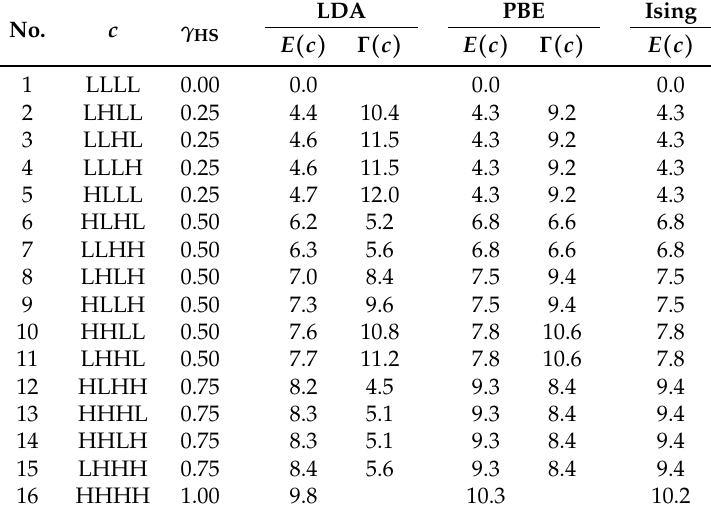
Table 1. Calculated total electronic energies per molecule, E ( c ) , Equation (5), and microscopic interaction parameters, Γ ( c ) , Equation (6), in kJ · mol − 1 for different spin configurations c as